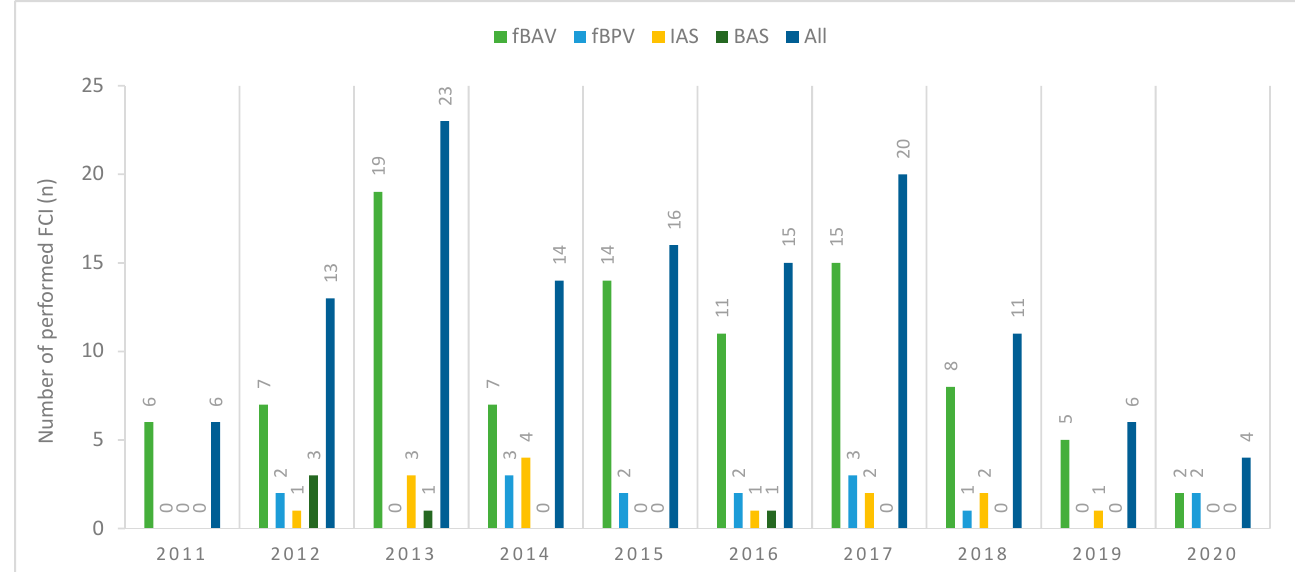
Figure 1. Number of fetal cardiac interventions (FCI) performed per year (from June 2011 until April 2020). fBAV: fetal balloon aortic valvuloplasty; fBPV: fetal balloon pulmonary valvuloplasty; IAS: interatrial stent placement; BAS: balloon atrial septoplasty; FCI: fetal cardiac intervention.